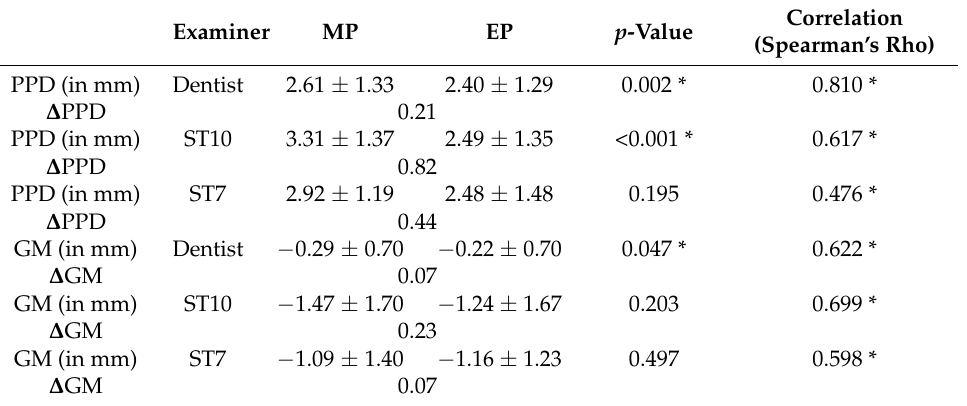
Table 3. Differences when measuring probing pocket depths (PPD) and gingival margins (GM) between manual probing (MP) and electronic probing (EP) in mm and its following percentages